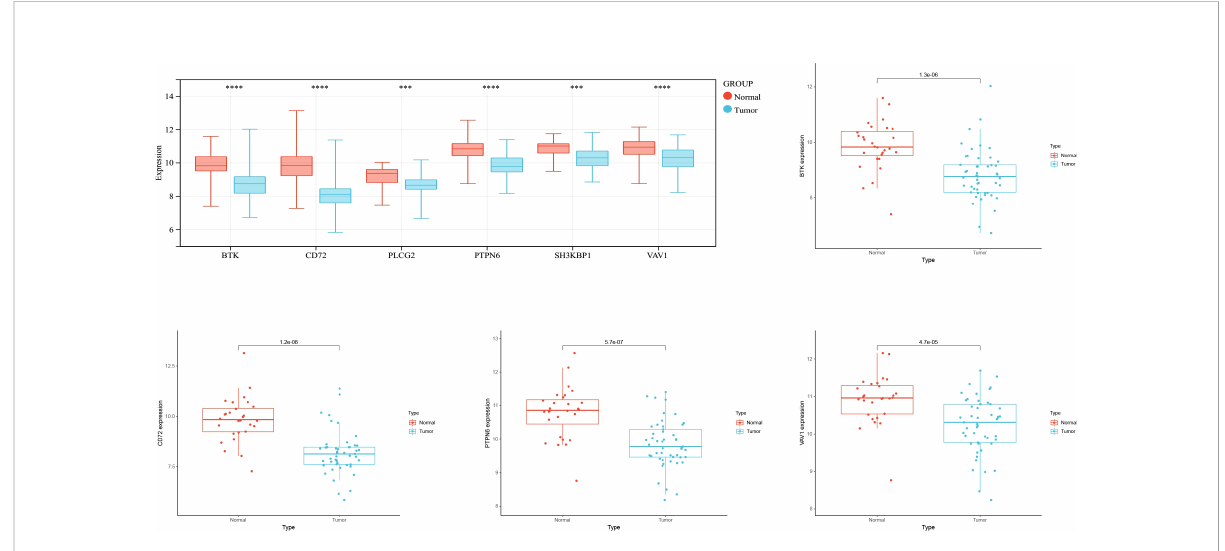
FIGURE 4 Expression analysis. ***indicates P < 0.001, ****indicates P <